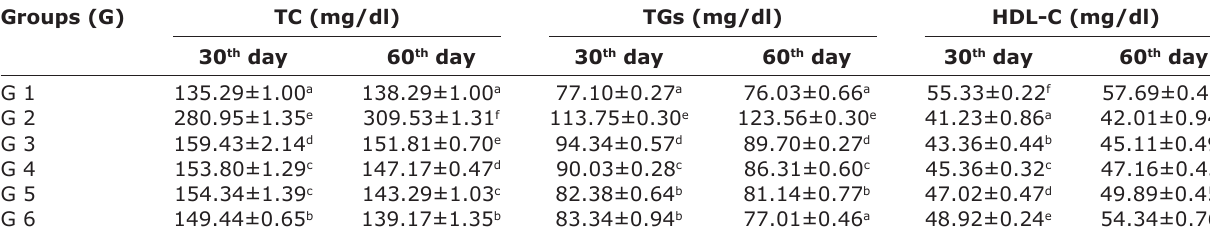
Values are mean±SE (n=6); Duncan’s multiple comparison test, means with different alphabets as superscripts differ significantly (p<0.05). SE=Standard error Table-2: Serum lipid profile in different groups of rats. Groups (G)